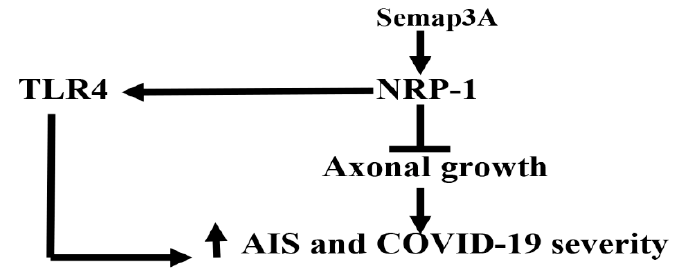
Figure 9. Role of semaphoring P3A (SemaP3A) in COVID-19 with acute ischemic stroke (AIS): Through activation of NRP-1, SemaP3A inhibit axonal outgrowth and expression of toll-like receptor 4 (TLR4), causing the augmentation of COVID-19 severity in AIS.